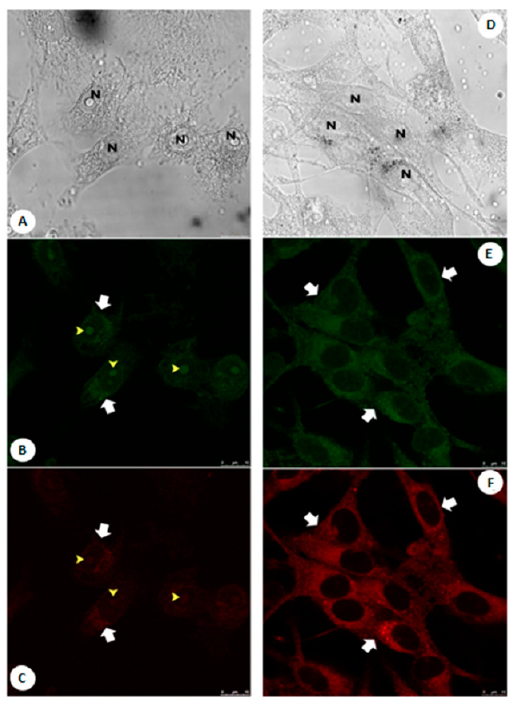
Figure 22. ( A − C ) Confocal fluorescence images of live MDA-MB-231 cells stained with compound 25 in the cytoplasm, preferentially, and mildly in the nucleus region, as indicated by yellow arrows. ( D − F ) Confocal fluorescence images of live MeWo cells stained with compound 26 in the perinuclear region, as indicated by white arrows. Scale bar: 10 μ m. Adapted from [62].